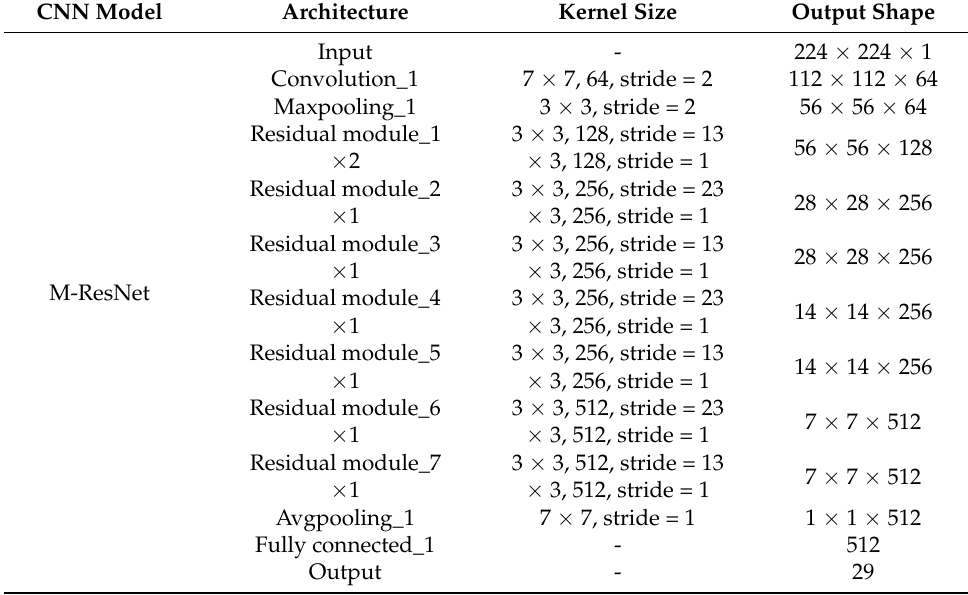
Table 5. The architecture of